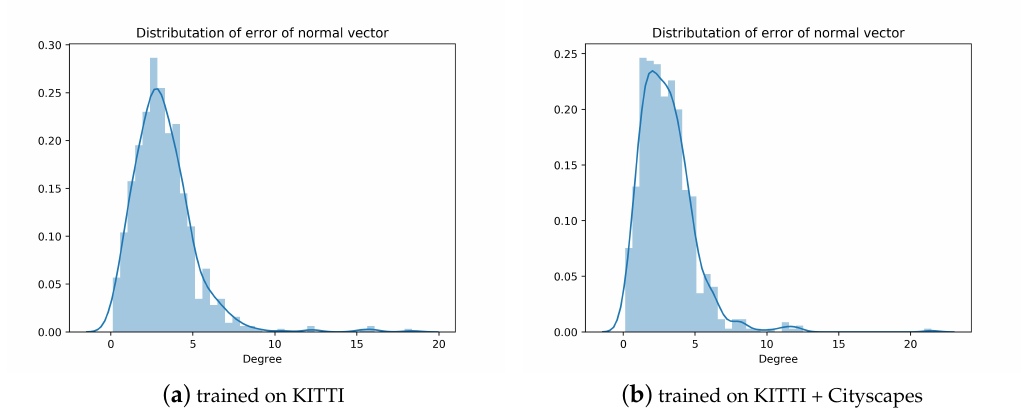
Figure 8. The error distribution of predicted ground normal vector. ( a ) shows prediction errors of the model trained on the KITTI raw data, while in ( b ) the corresponding model is trained on both Cityscapes and KITTI raw